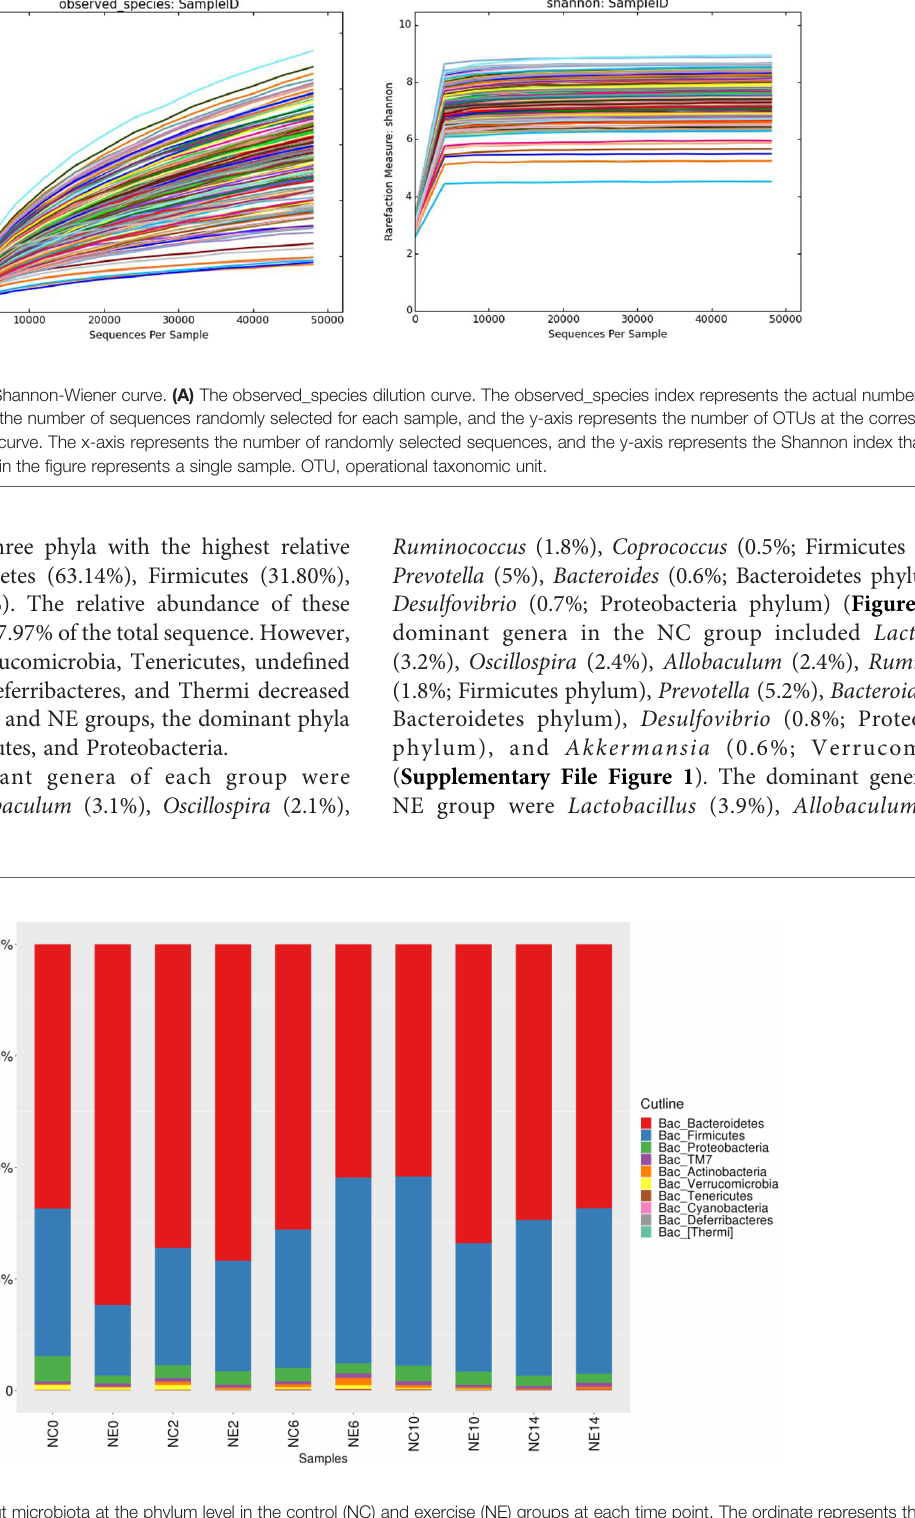
FIGURE 5 | Histogram of the gut microbiota at the phylum level in the control (NC) and exercise (NE) groups at each time point. The ordinate represents the relative abundance of phyla. Different colors represent different